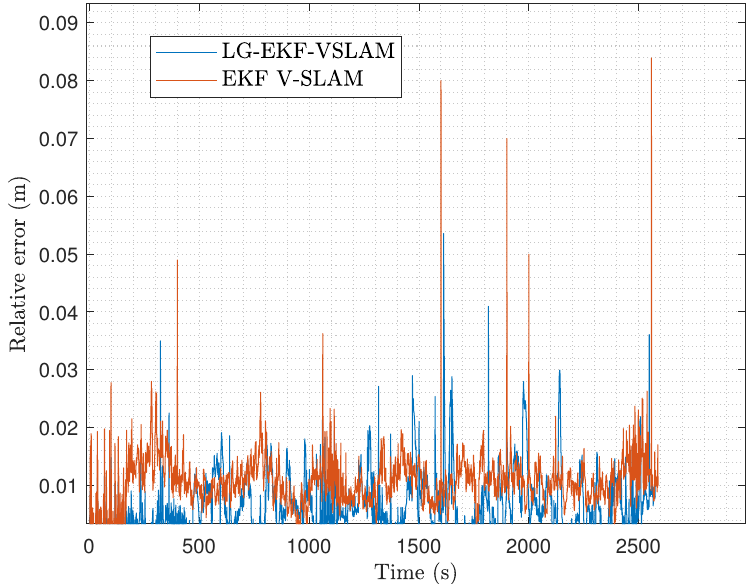
Figure 9. Absolute position error obtained for the two